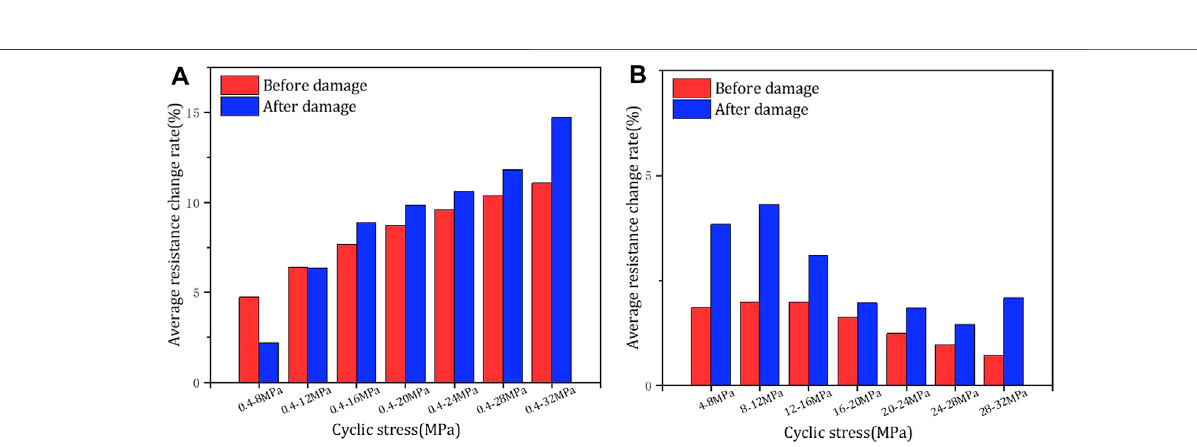
Frontiers in Built Environment |